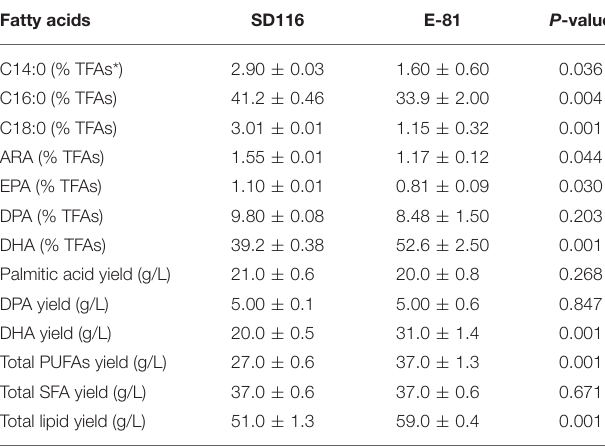
TABLE 1 | The analysis of lipid and fatty acid composition in SD116 and E-81 at the end-point of fed-batch fermentation (5th day). Fatty